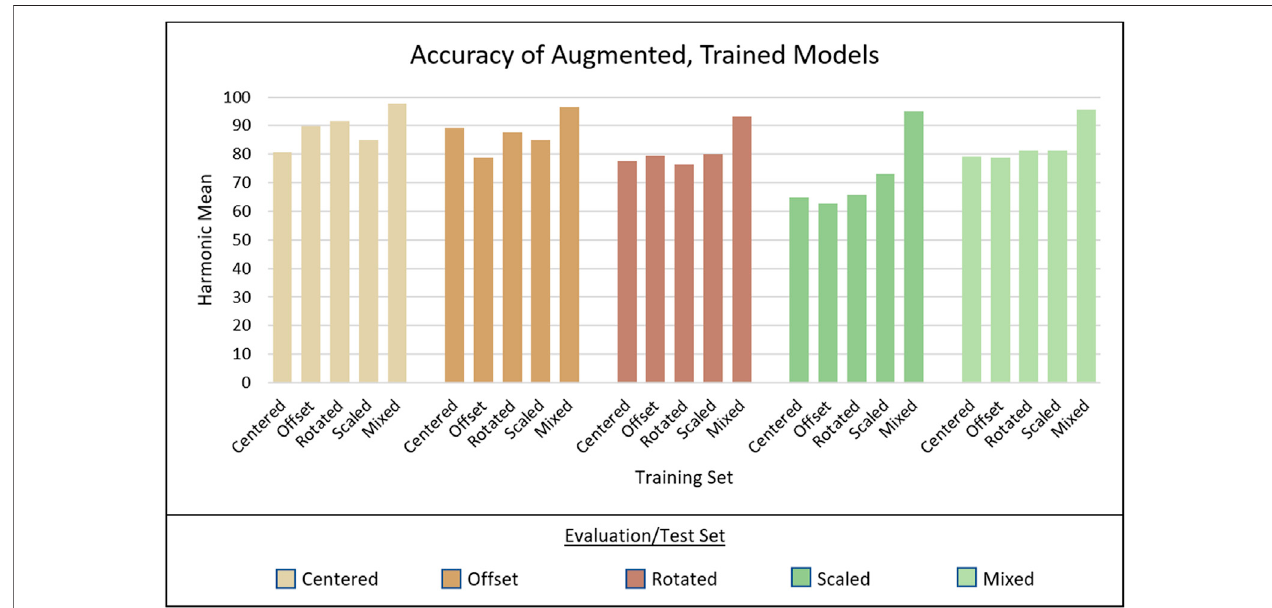
FIGURE9| Visualizationoftheharmonicmean(Hmean)foreachevaluationoutput.Thebottomaxisdisplayswhichsetthemodelwastrainedonandeachgroupof 5 are results from a single evaluation set.